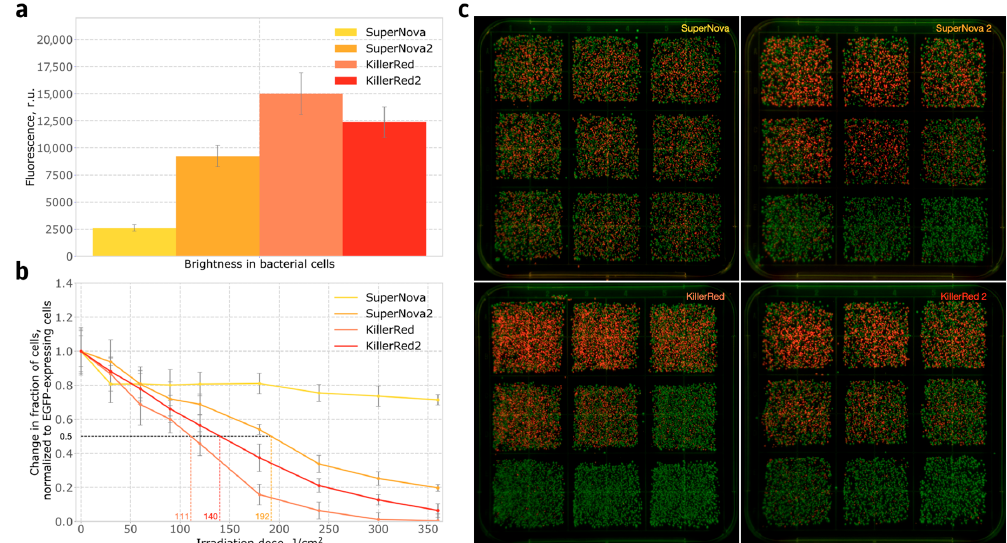
Figure 3. Expression of phototoxic fluorescent proteins in bacteria: ( a ) Brightness in bacterial cells after incubation for 20 h at 37 °C and another 24 h at room temperature; ( b ) Phototoxicity of SuperNova, SuperNova2, KillerRed and KillerRed2 in bacteria; ( c ) Photographs of plates with bacterial colonies expressing EGFP and one of the photosensitizers, plated after light irradiation experiment. Each squared section represents a single time point (0.0, 0.5, 1.0, 1.5, 2.0, 3.0, 4.0, 5.0 and 6.0 min, which is equivalent to the irradiation dose 0, 30, 60, 90, 120, 180, 240, 300 and 360 J/cm2. Ordered from left to right and from top to bottom). Indicative irradiation dose values required for ablation of 50% of cells are shown on the X axis in colour.